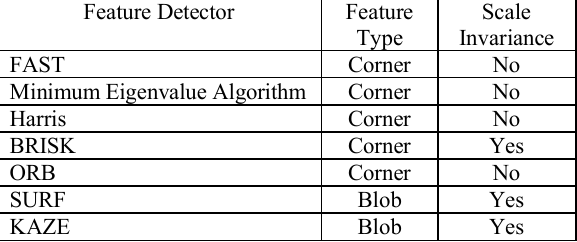
Table 1. Feature detectors used in this study.